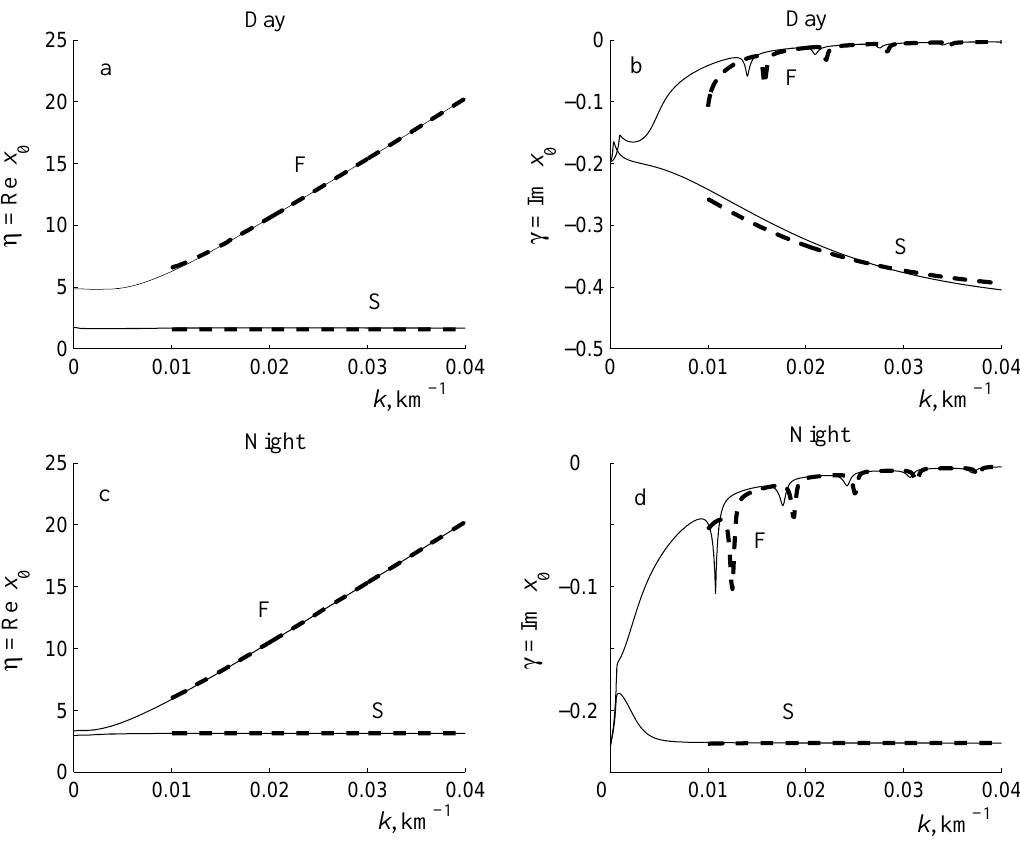
Fig. 3. The plots of the real (a, c) and imaginary (b, d) parts of the dimensionless frequency x 0 as a function of perpendicular wave number k for the fundamental mode. S and F denote the shear Alfv´en and fast modes, respectively. The dashed lines correspond to the approximate analytical